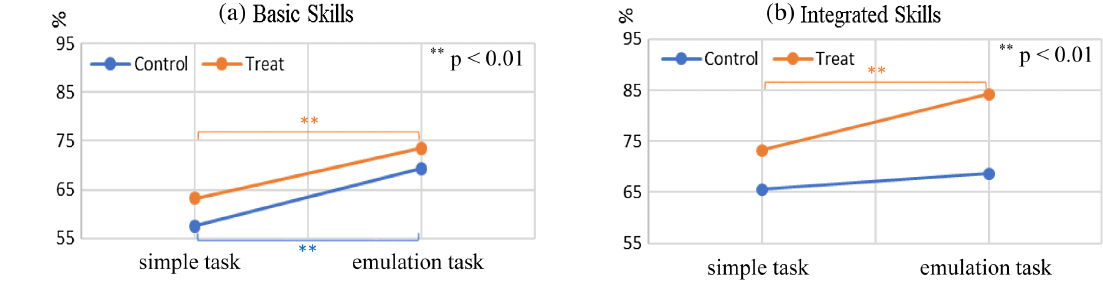
FIG. 6. Students ’ inquiry performance of (a) basic SPS, and (b) integrated SPS.